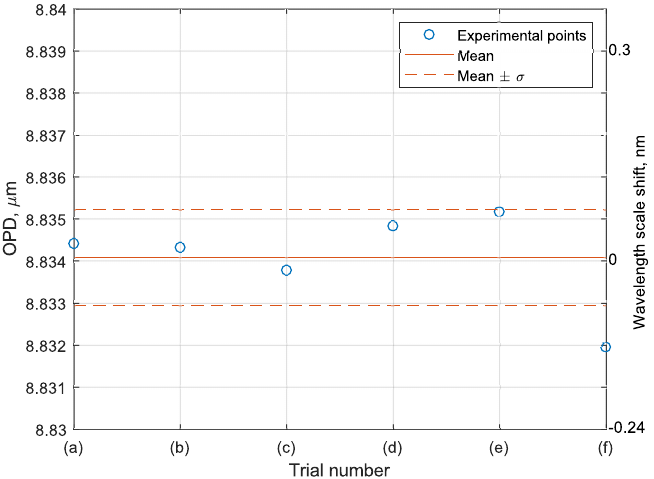
Figure 7. Interferometer optical path differences (OPD) values (left vertical axis) and corresponding spectra wavelength shifts (right vertical axis) demodulated from the spectra shown in Figure 6a–f. Solid line shows the mean OPD and dashed lines show the standard deviations of the experimental